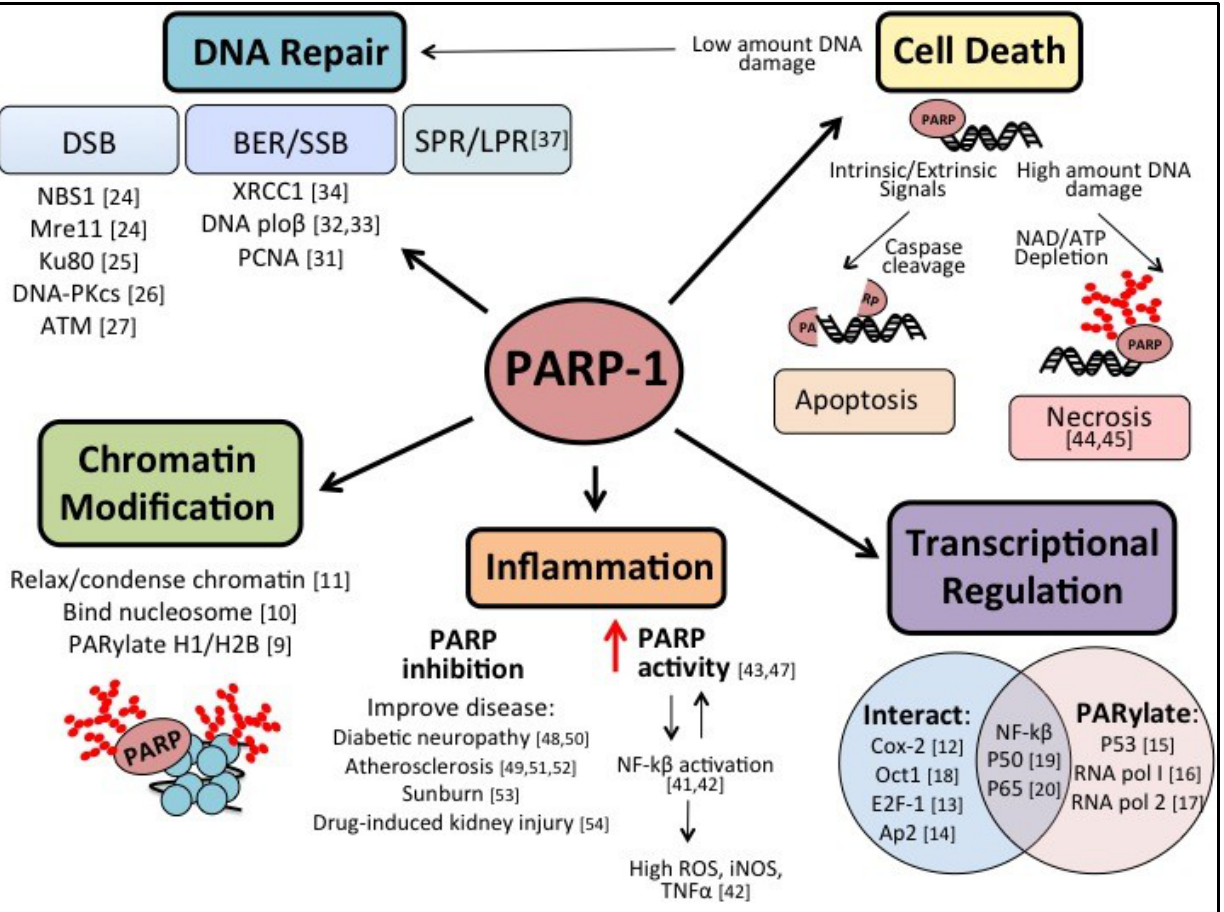
Figure 1. Schematic delineating the multifaceted nature of Poly(ADP) Ribose Polymerase (PARP): DNA repair, Chromatin Modification, Inflammation, Transcriptional Regulation, and Cell